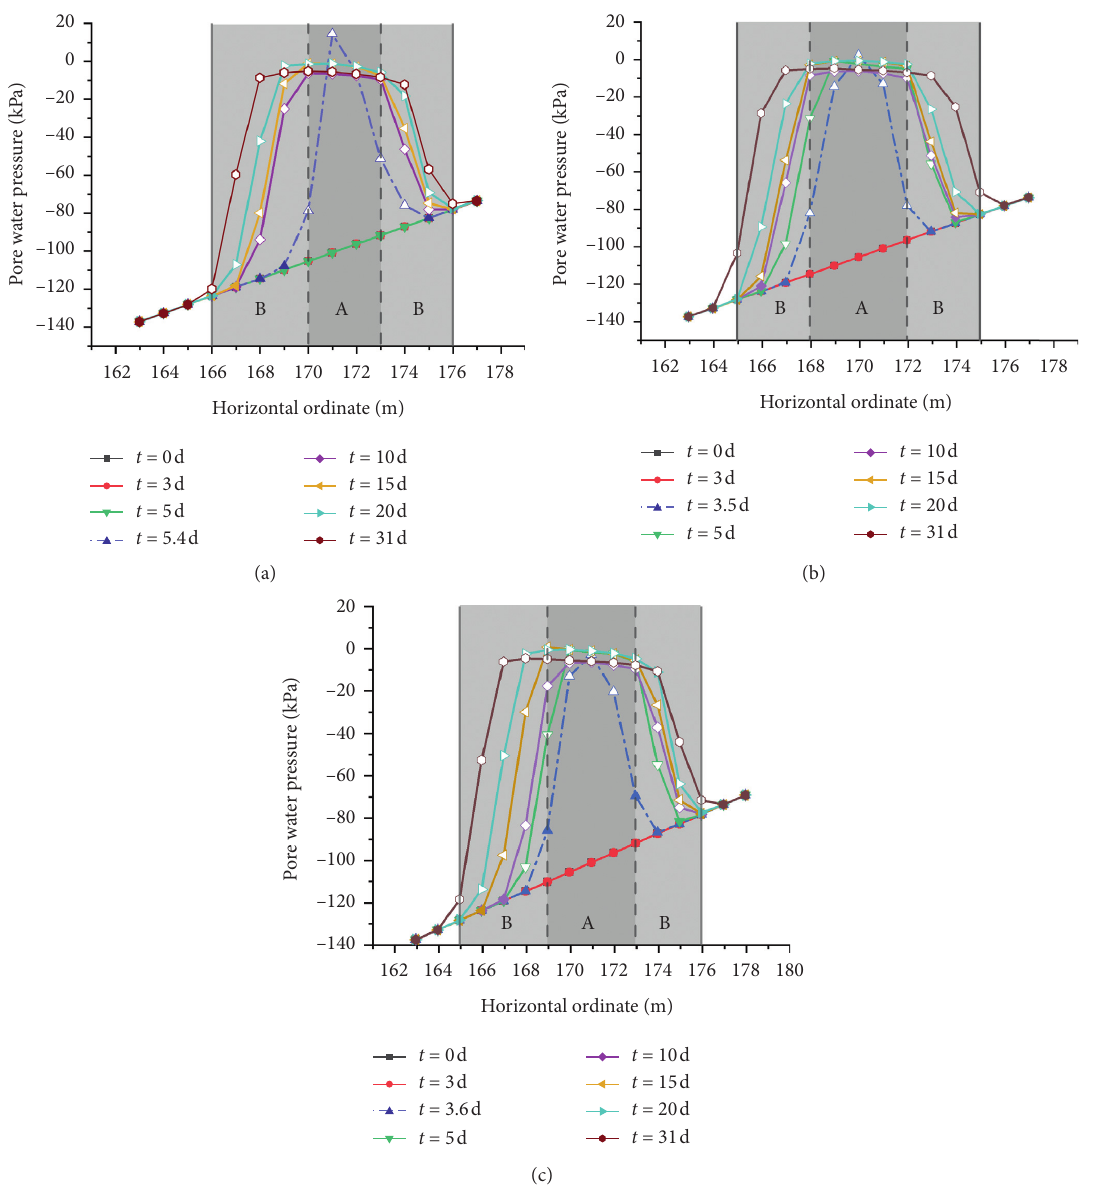
Figure 12: Pore water pressure distribution of the cracking slope with an anisotropic degree of permeability as (a) 0.1; (b) 1.0; (c)